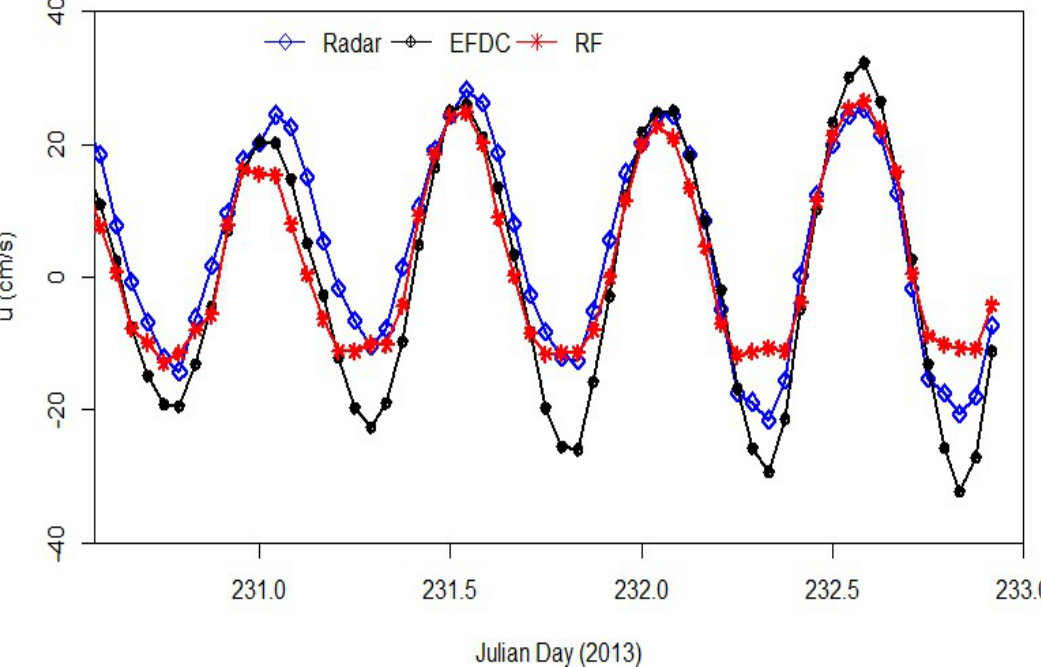
Figure 3. Predictions of zonal surface velocity component at point P1.